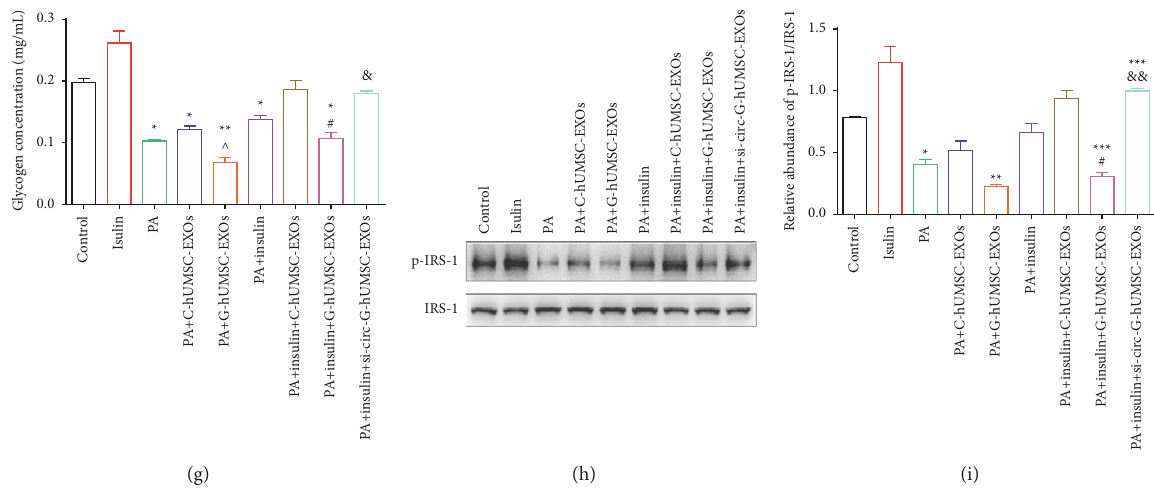
Figure 4: Si-circ-G-mUMSC-EXOs ameliorated glucose and insulin resistance in GDM mice. (a) Inhibitory effects of three potential siRNAs targeting mmu_circ_0002819 as determined by RT-qPCR assay ( ∗ P < 0 . 05, si-mmu_circRNA1, mmu_si-circRNA2 and mmu_si- circRNA3 vs. Control; ### P < 0 . 001, si-mmu_circRNA1, mmu_si-circRNA2 and mmu_si-circRNA3 vs. siNC). (b) Inhibitory effect of sh- mmu_circ_0002819 on mmu_circ_0002819 expression in mUMSCs and mUMSC-EXOs as evaluated by RT-qPCR. ∗ P < 0 . 05, ∗∗ P < 0 . 01 (c) Serum glucose level in mice from the five groups following glucose tolerance test ( ∗∗ P < 0 . 01, ∗∗∗ P < 0 . 001, vs. Control; ^ P < 0 . 05, ^^ P < 0 . 01, GDM vs. GDM +si-circ-G-mUMSC-EXOs; ## P < 0 . 01, GDM +G-mUMSC-EXOs vs. GDM +si-circ-G-mUMSC-EXOs). (d) Serum